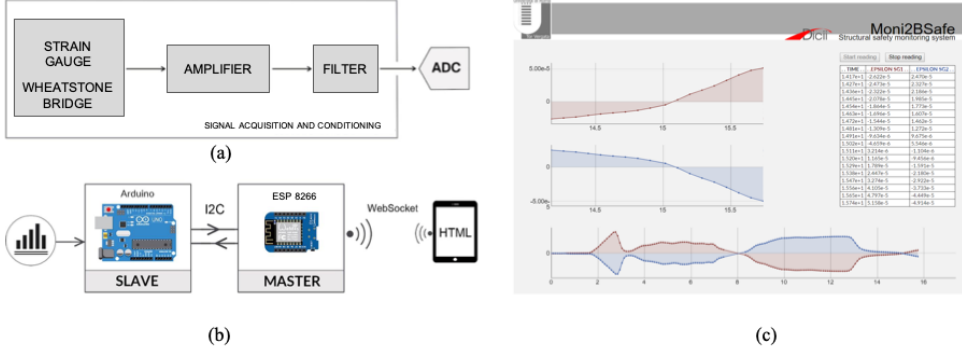
Figure 3: Low-cost device. (a) Sensor layout. (b) Communication layout. (c) Web browser